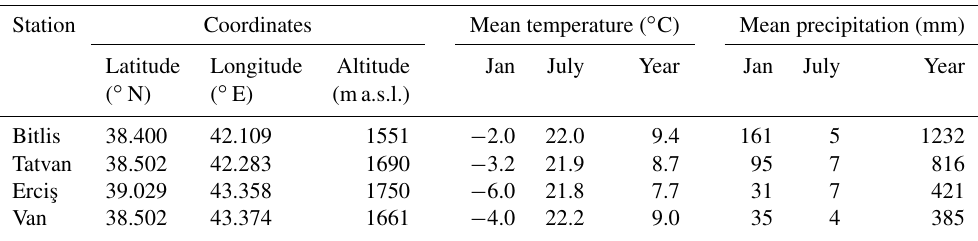
Table 1. Present-day climate data at Lake Van (see Fig. 1 for the location). Data were provided by the Turkish State Meteorological Service (observation period: 1975–2008). Station Coordinates Mean temperature ( ◦ C)